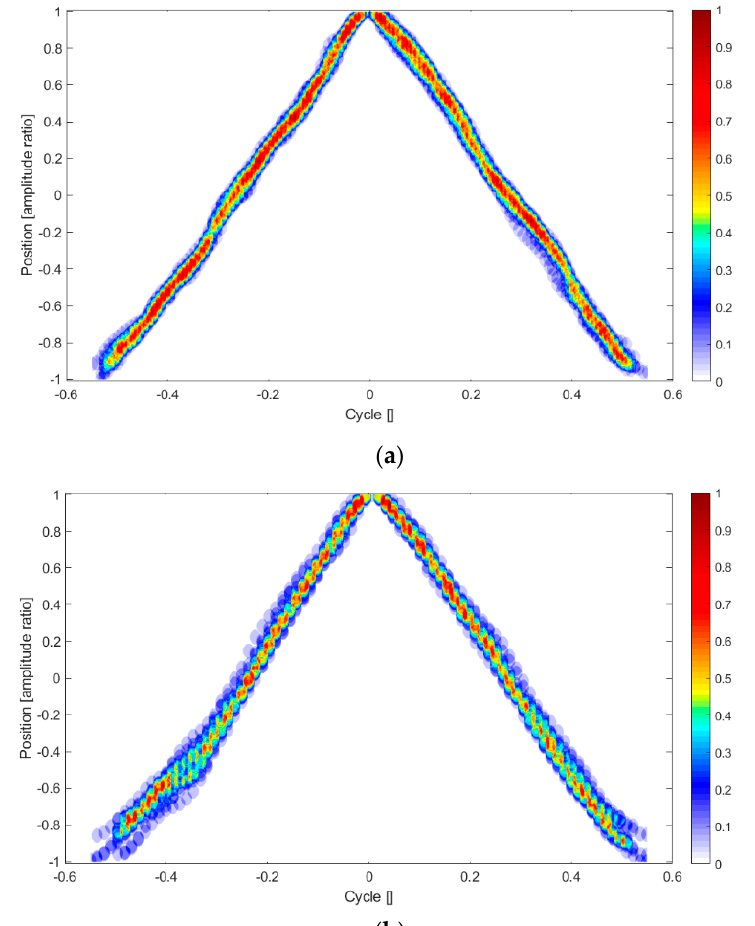
Figure 8. PDF of the individual “teeth” to overlap with the mean in the zig-zag motion profile for a selected flap in air ( a ) and glycerol ( b ) for a total period of 1 min. Blue values show a larger deviation from the mean, while red is aligned with the mean of all teeth. Note that all teeth are fixed with their maximum position at beginning of cycle time 0.